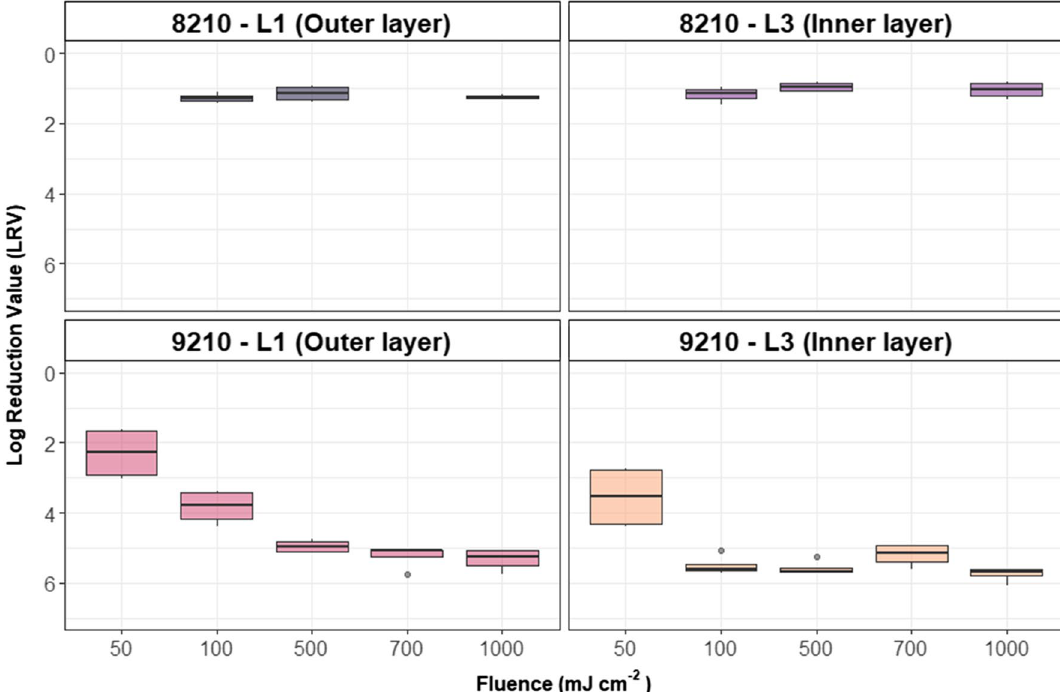
Figure 4. MS2 fluence–response curve for four combinations of respirator-type and respirator layers (Fig. 1a,b) with UV-C 280 nm irradiation. Each box represents each of 2 technical replicates for each of 2 biological replicates for a total of 4 data points. An outlying dot indicates data points that are 1.5 * IQR (interquartile range) outside the first or third